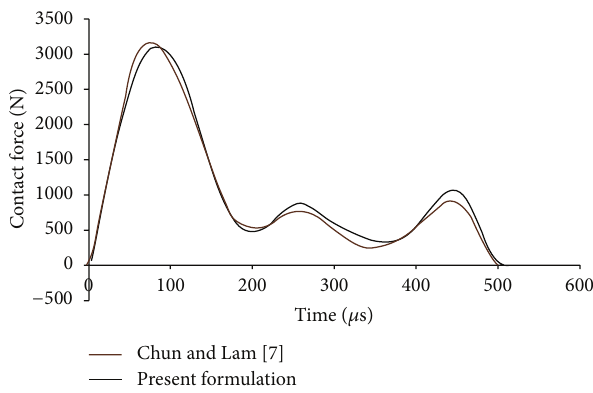
Figure 1: Surface of a skewed hypar shell and degrees of freedom. Figure 2: Contact force history of clamped plate. 𝐸 11 = 142.73 GPa,